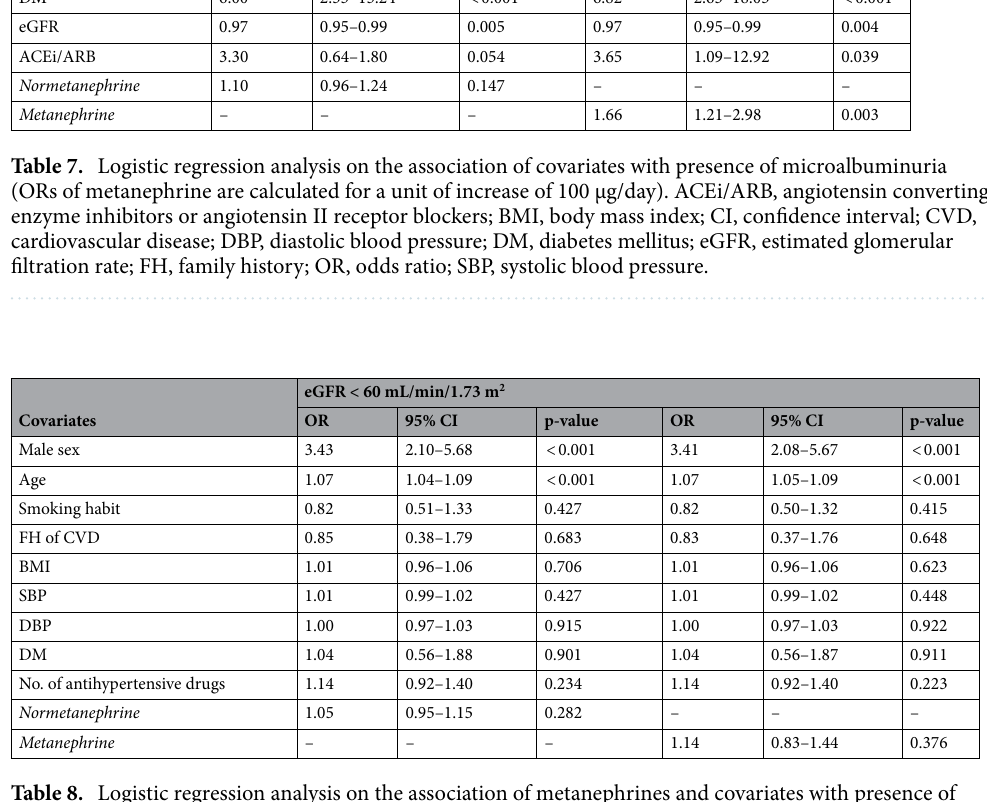
Table 8. Logistic regression analysis on the association of metanephrines and covariates with presence of eGFR < 60 mL/min/1.73 m 2 (ORs of normetanephrine and metanephrine are calculated for a unit of increase of 100 μg/day). BMI, body mass index; CI, confidence interval; CVD, cardiovascular disease; DBP, diastolic blood pressure; DM, diabetes mellitus; eGFR, estimated glomerular filtration rate; FH, family history; OR, odds ratio; SBP, systolic blood